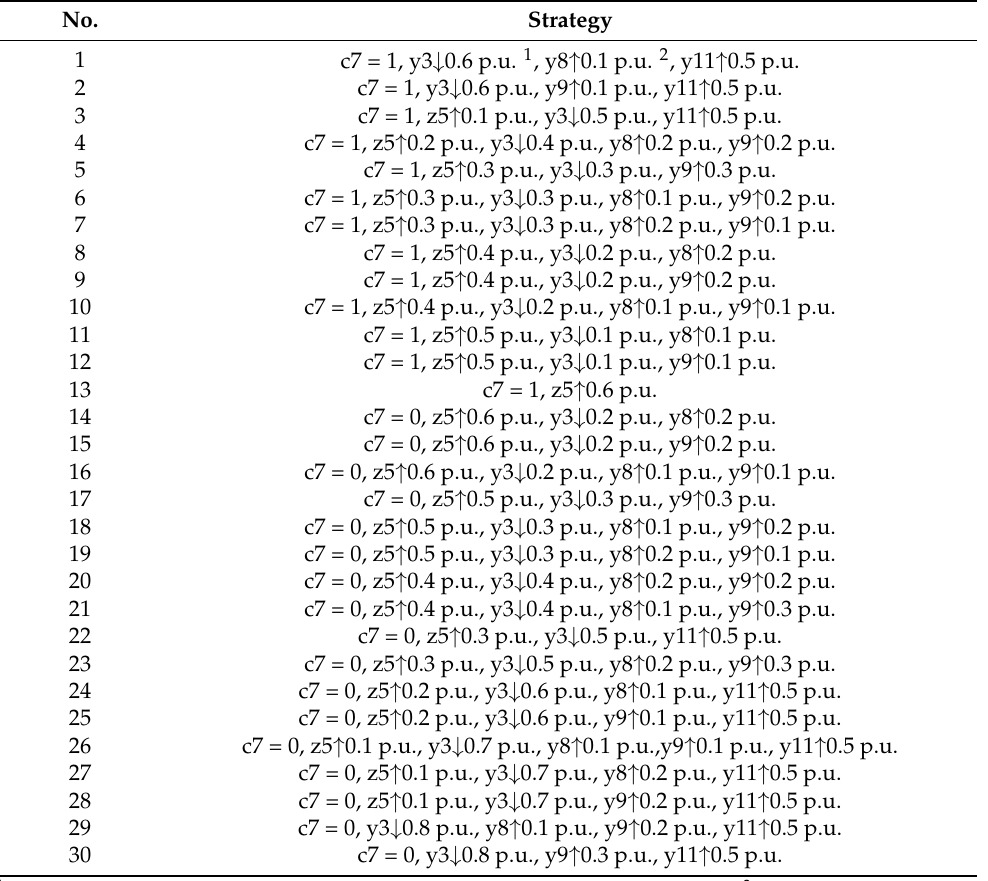
Table 10. Protection and control strategies for alleviating overloads.